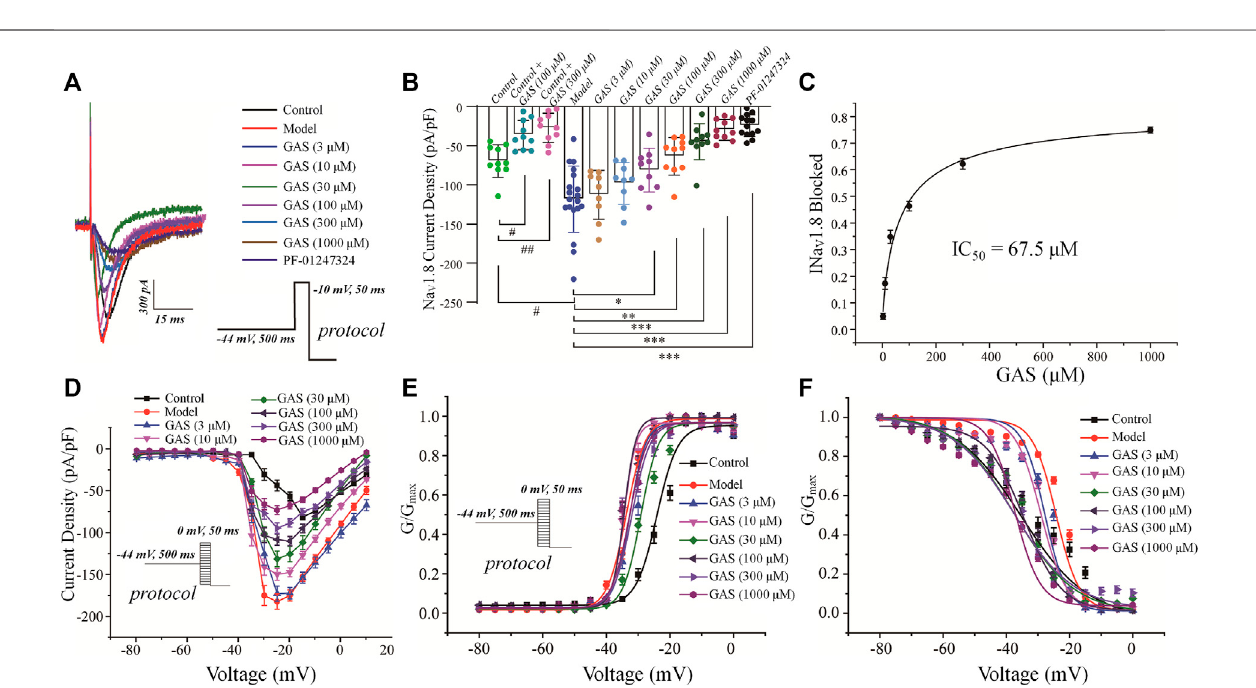
FIGURE4| EffectsofGASonNa V 1.8channelcurrentinDRGneuronsfrommodelrats: (A) typicalcurveofGASinhibitingNa V 1.8channelcurrentofDRGneurons; (B) histogram of theinhibitory effects of GASon the current density; (C) concentration-responsecurves ofGAS on Na V 1.8 current (IC 50 (cid:1) 67.5 ± 20.7 μ M); (D) in fl uence of different doses of GAS on the current density-voltage relationship of DRG neurons. (E) effects of different concentrations of GAS on the activation curve of Na V 1.8 channel; (F) in fl uenceofdifferentconcentrationsofGASontheinactivationcurveofNa V 1.8channelofDRG neurons(# p < 0.05,compared tothecontrolgroup; *p < 0.05, **p < 0.01, ***p < 0.001, compared to the model group; ANVOA- Bonferroni